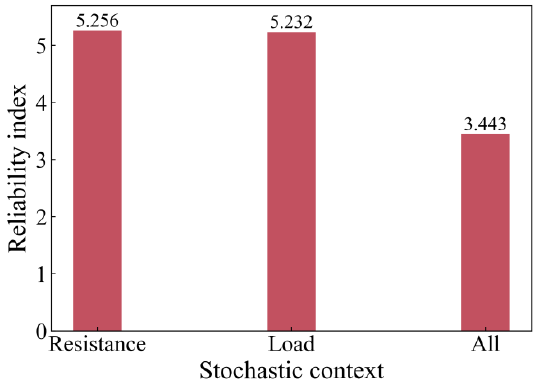
Figure 12. The reliability index in different stochastic contexts.